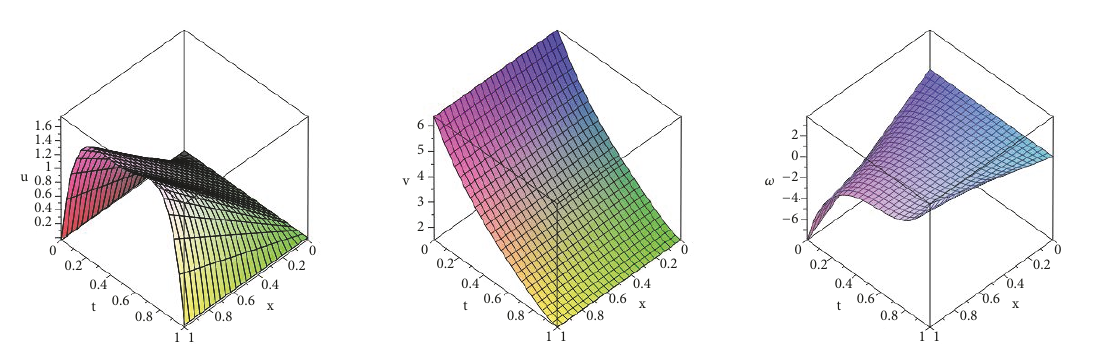
Figure 13: Surface of 𝑢 , V , and 𝜔 for 𝑀 = 1 , 𝑆 = −14 , 𝛾 = 0 . 1 , 𝑦 = 1 , 𝛼 = −3 , 𝑙 = 2 .